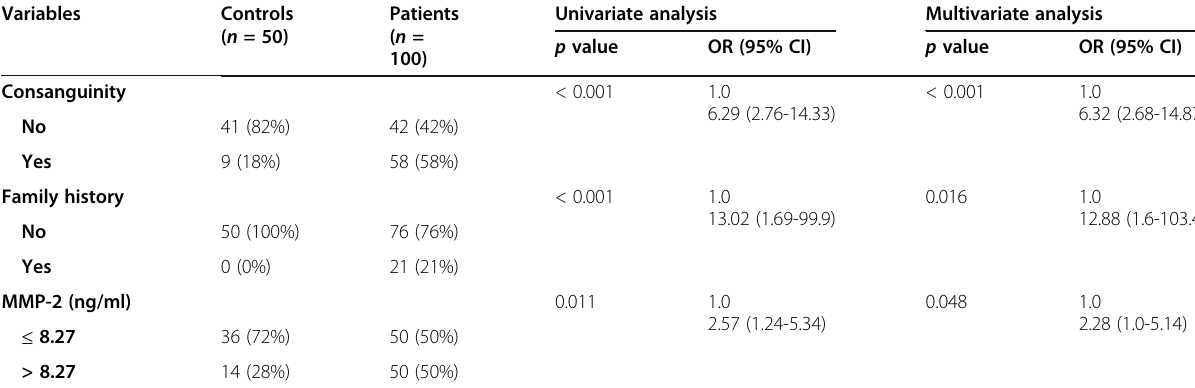
Table 4 Uni- and multivariate analysis to estimate the effects of consanguinity and family history on MMP2 levels